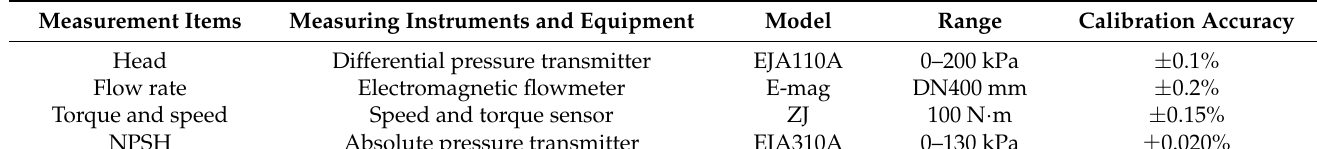
Table 2. Basic geometric parameters of the pumping device.